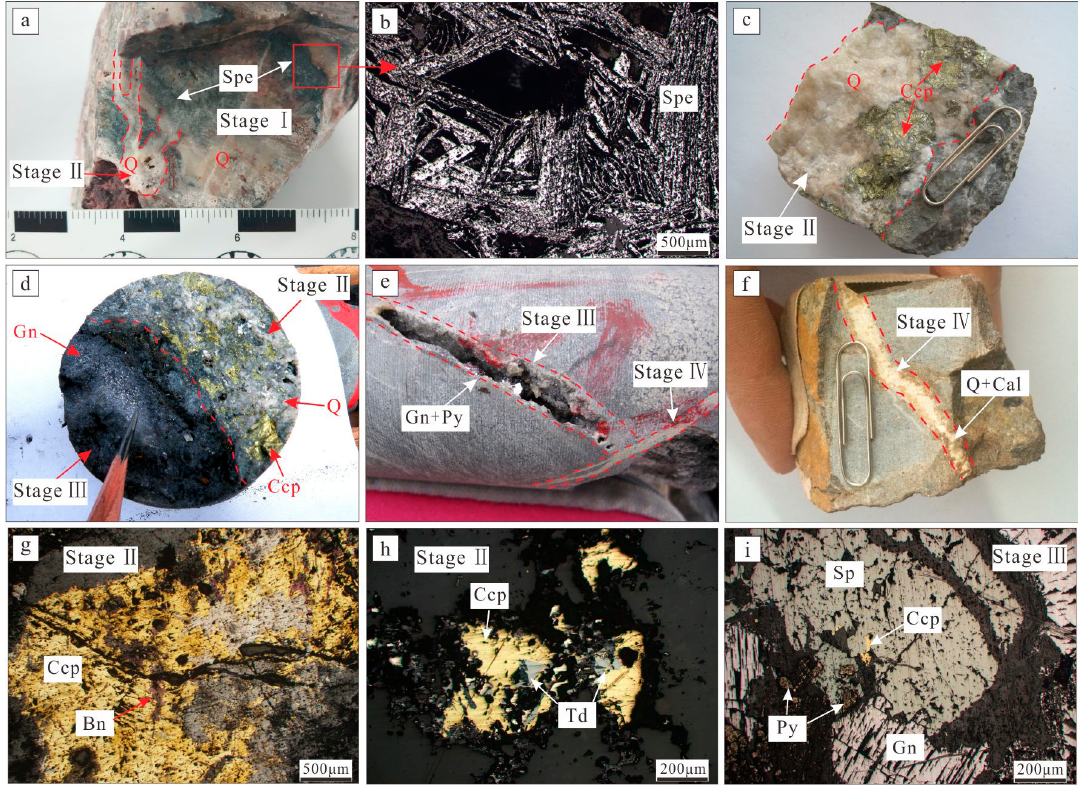
Figure 4. Photographs and photomicrographs of ore from the Chuduoqu Pb-Zn-Cu deposit. ( a ) Stage II quartz-chalcopyrite vein crosscutting stage Ⅰ quartz-specularite vein; ( b ) Specularite in stage I; ( c ) Stage II quartz-chalcopyrite vein crosscutting wall rock; ( d ) Stage III galena crosscutting stage II quartz-chalcopyrite vein; ( e ) Stage II quartz-carbonate vein crosscutting stage III quartz-galena-pyrite vein; ( f ) Stage II quartz-carbonate vein crosscutting wall rock; ( g ) Chalcopyrite intergrown with bornite in stage II; ( h ) Chalcopyrite intergrown with tetrahedrite in stage II; ( i ) Sphalerite intergrown with galena, little chalcopyrite and pyrite in stage III. Q—quartz; Cal—Calcite; Spe—specularite; Py—pyrite; Ccp—chalcopyrite; Sp—sphalerite; Gn—galena; Bn—bornite; Td—tetrahedrite.